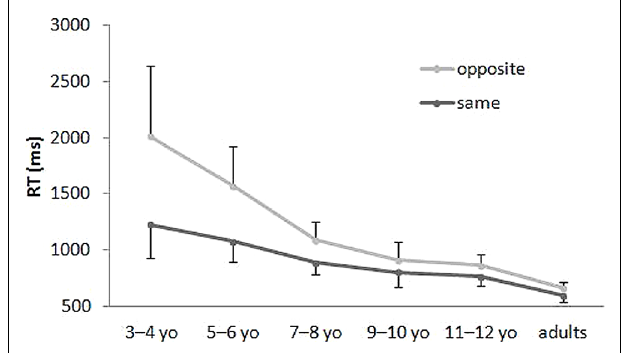
FIGURE 3 | Mean RT in the Stroop-like big–small. Error bars represent standard